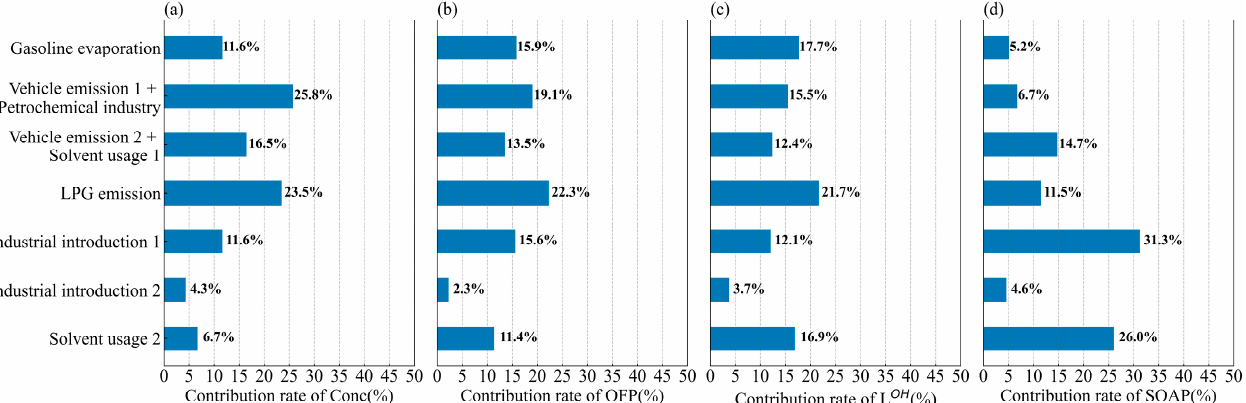
Figure 10. The source contributions to the concentrations ( a ) of OFP ( b ), L OH ( c ) and SOAP ( d ) in the spring.